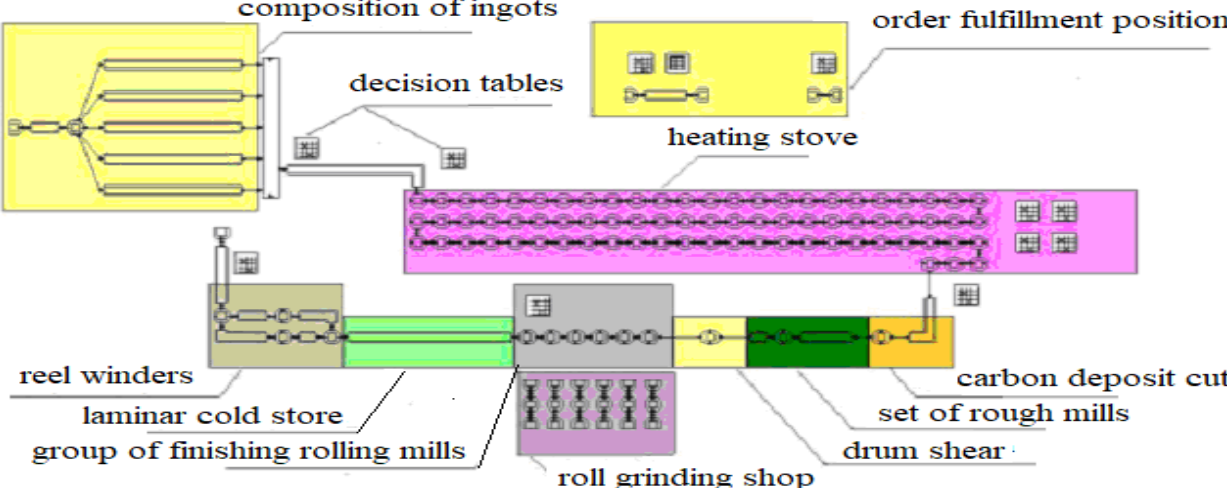
Figure 10. Validation model of the production system hot strip mills. Source: own study.